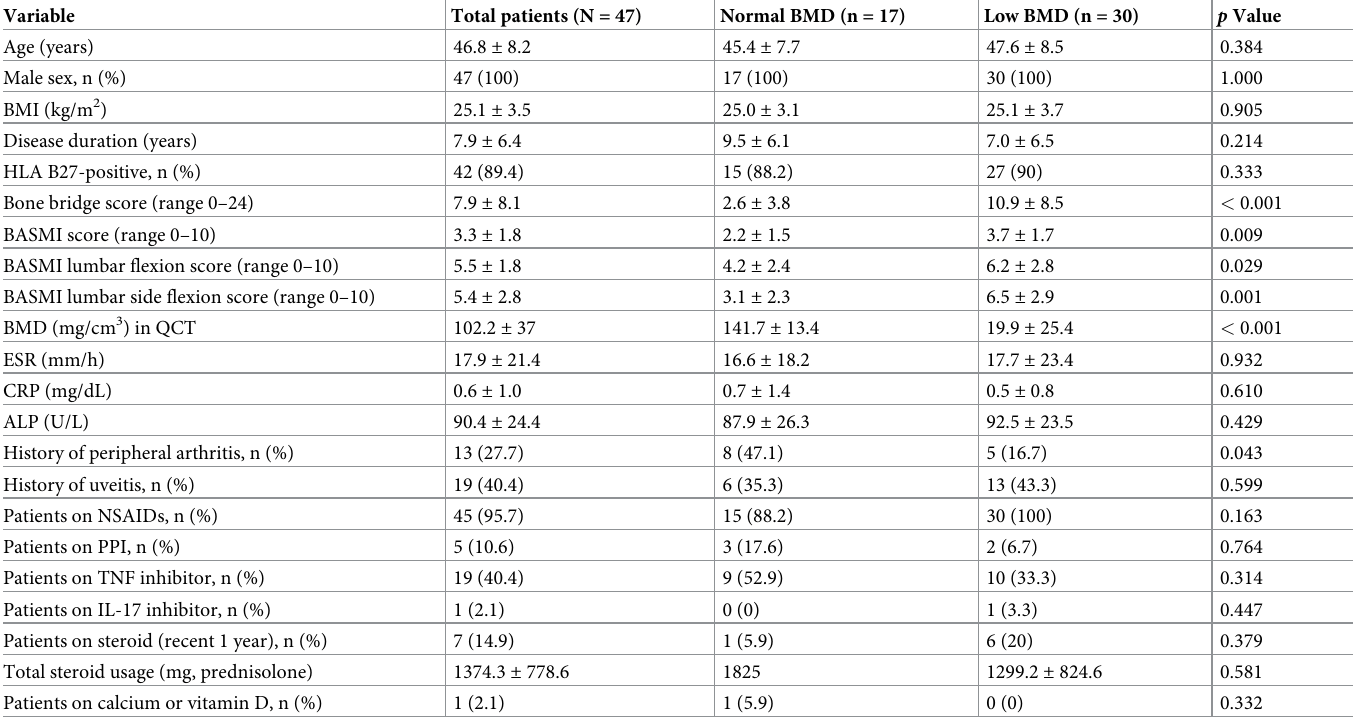
Table 1. Baseline characteristics.